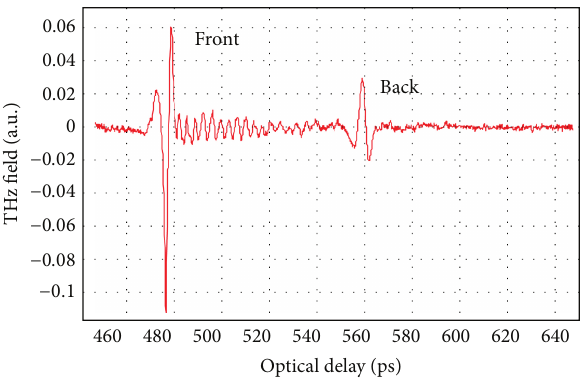
Figure 6: THz TDS pulses reflected from the front and back